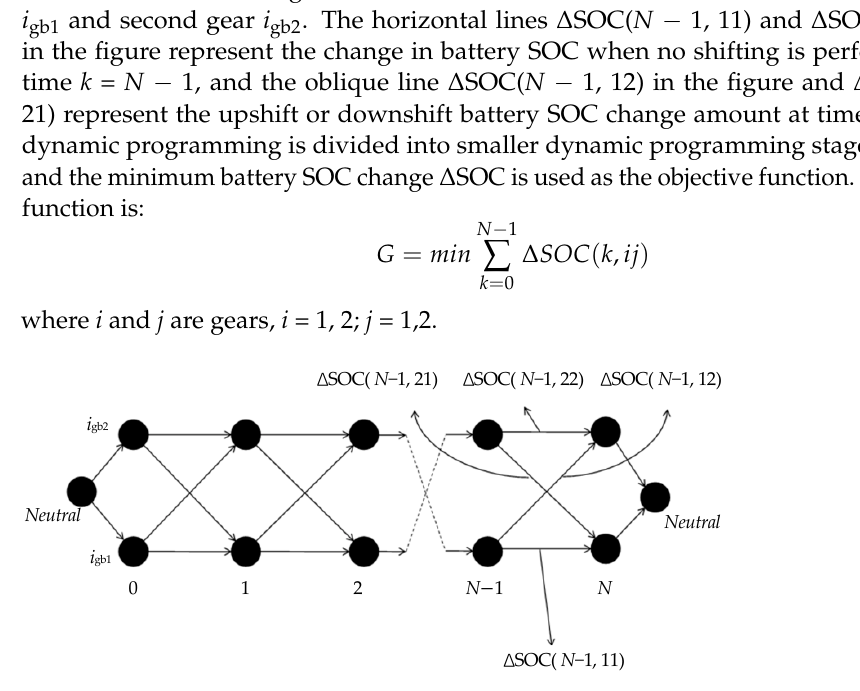
Figure 9. Dynamic Figure 9. Dynamic programing. Figure 9. Dynamic programing.